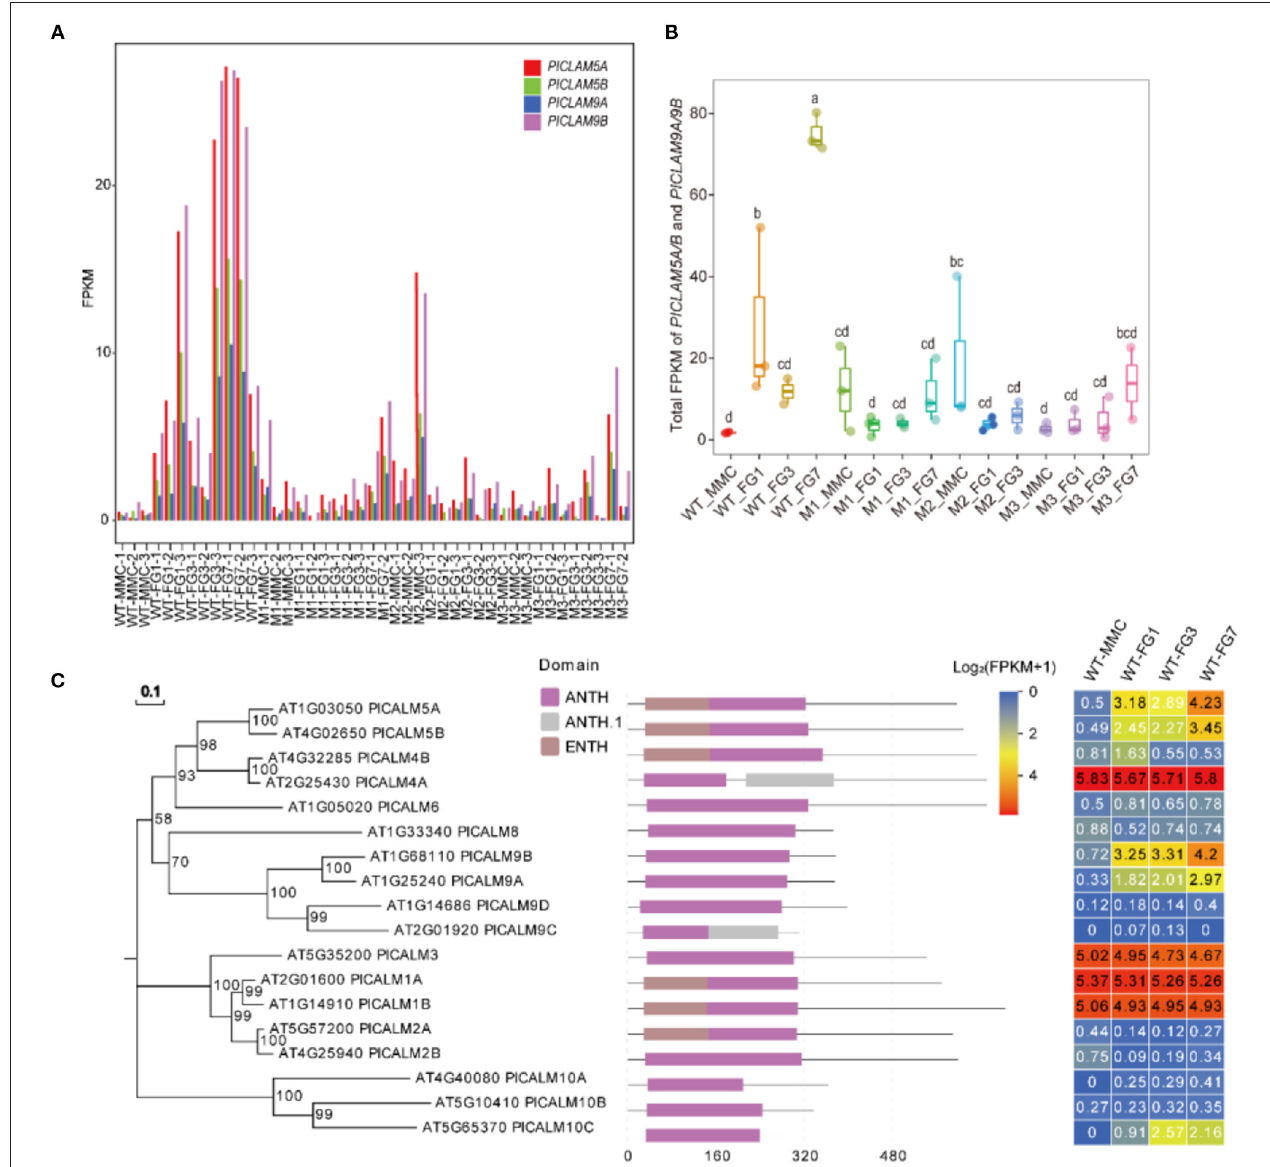
FIGURE 7 | (A) FPKM value of PICALM5A/B and PICALM9A / B at each stage in WT, M1, M2, and M3. (B) The total FPKM values of the four PICALMs at each stage in WT, M1, M2, and M3. The lowercase letters above the bars mean significant difference ( p < 0.05). (C) The expression profiles of each member of the ANTH family. Bootstraps (based on 1,000 replications) of the un-rooted phylogenetic tree are indicated at each node (bar = 0.1 amino acid substitutions per